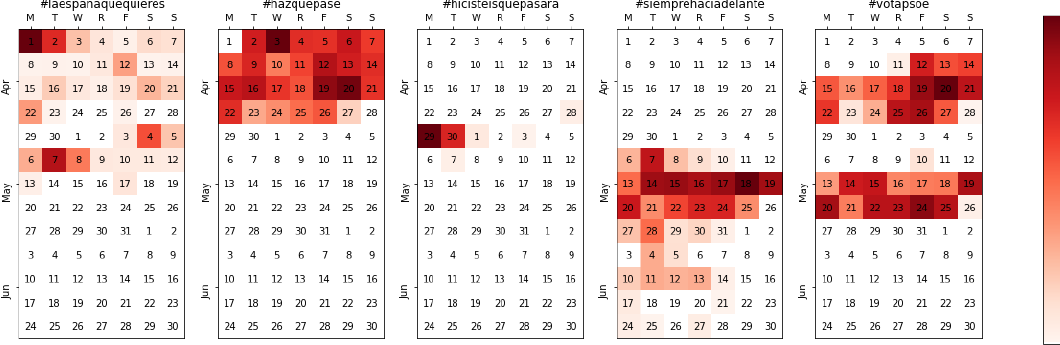
Figure 9. The evolution of PSOE-related hashtags, since the Spanish general elections pre-campaign to the European post-campaign.